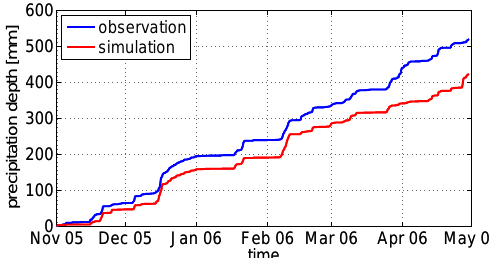
Figure 7. Comparison of observed and simulated mean areal pre- cipitation depth. The cumulative precipitation depth is derived by calculating the arithmetic mean of 19 stations and 19 corresponding grid points of the limited-area model. At this stage, no correction approach was applied to the observed time series, e.g., to correct wind induced errors. Please refer to Table 5 for further details in- cluding performance